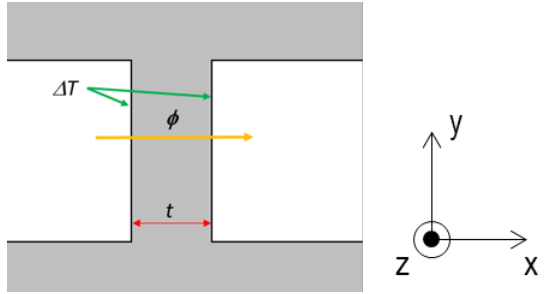
Figure 4. Sketch of the quantities used for the evaluation of the effective thermal conductivity.